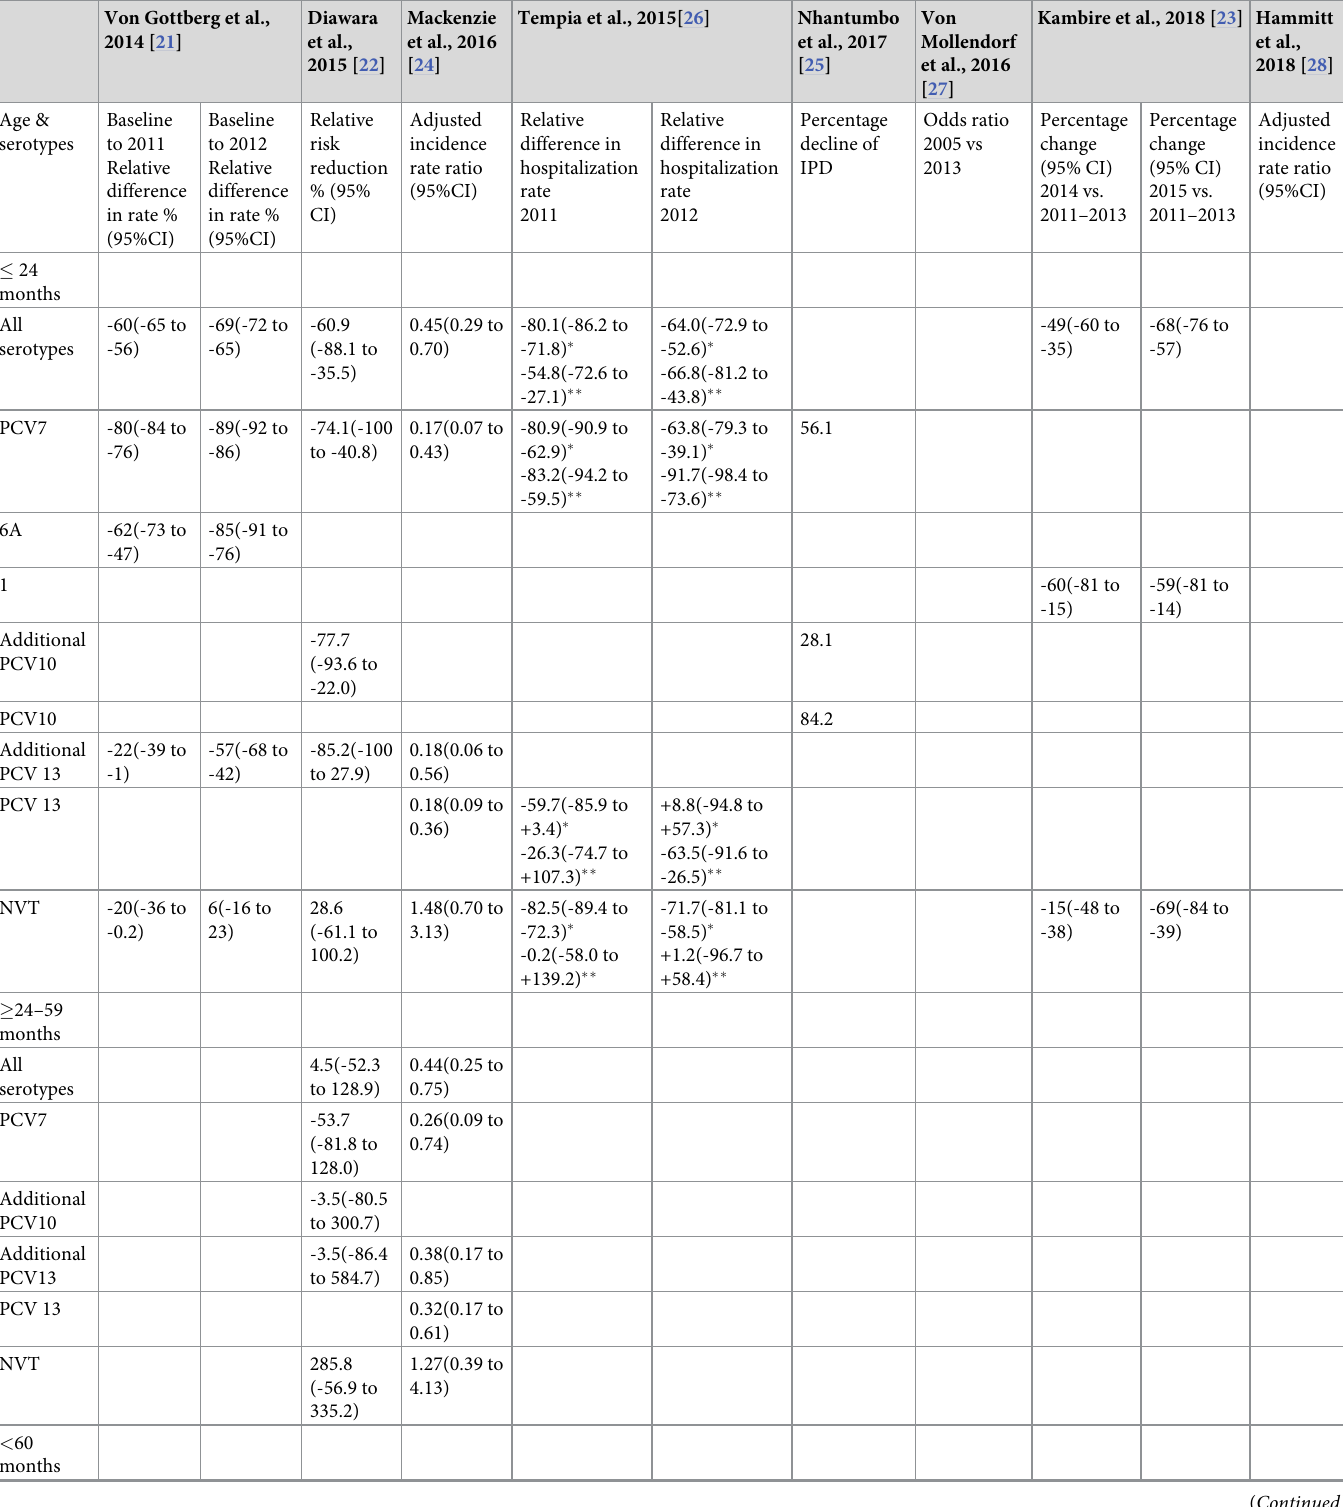
Table 2. Effectiveness of PCV in the prevention of IPD among children under five years of age. Von Gottberg et al., 2014